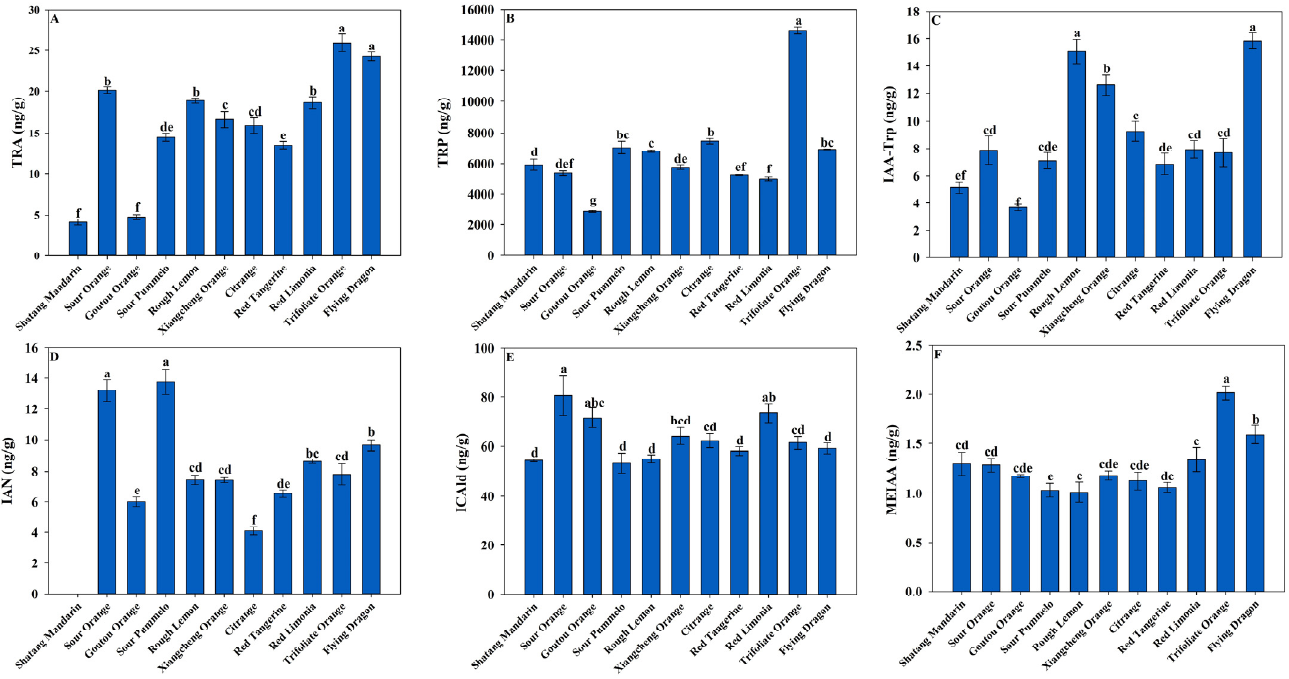
Figure 3. Endogenous auxin concentrations in leaf tissues of ‘Shatangju’ scion cultivar grafted onto different rootstocks. TRA = tryptamine ( A ), TRP = tryptophan ( B ), IAA-Trp = tryptophan ( C ), IAN = Indole-3-acetonitrile ( D ), ICAld = indole-3-carboxaldehyde ( E ) and MEIAA = methyl indole-3-acetate ( F ). Error bars indicate the standard error of three biological replicates, and lowercase letters indicate significant differences between rootstocks by LSD ( p ≤ 0.05).